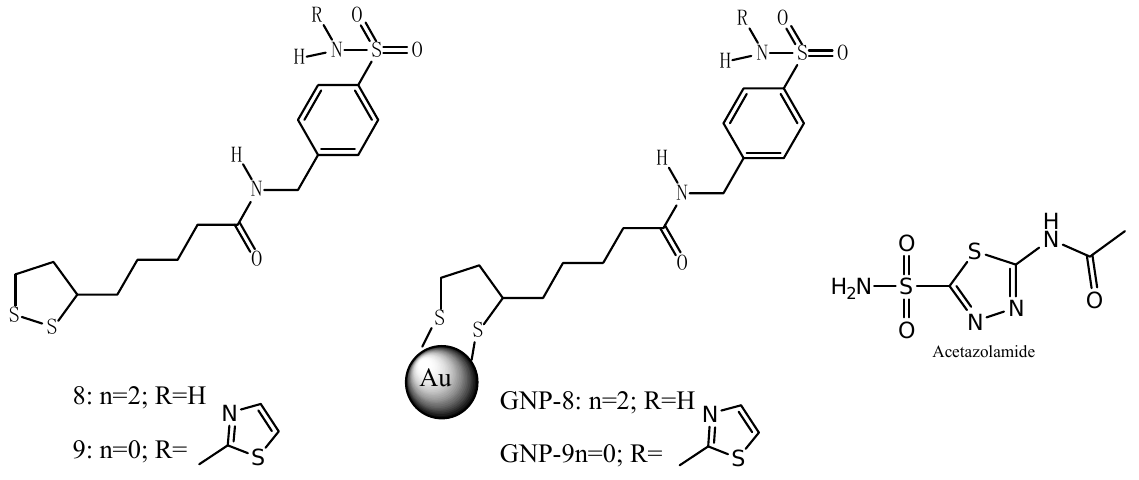
Figure 6. Structure of the acetazolamide AZA, the new sulfonamides 8 , 9 , GNP-8 and GNP-9